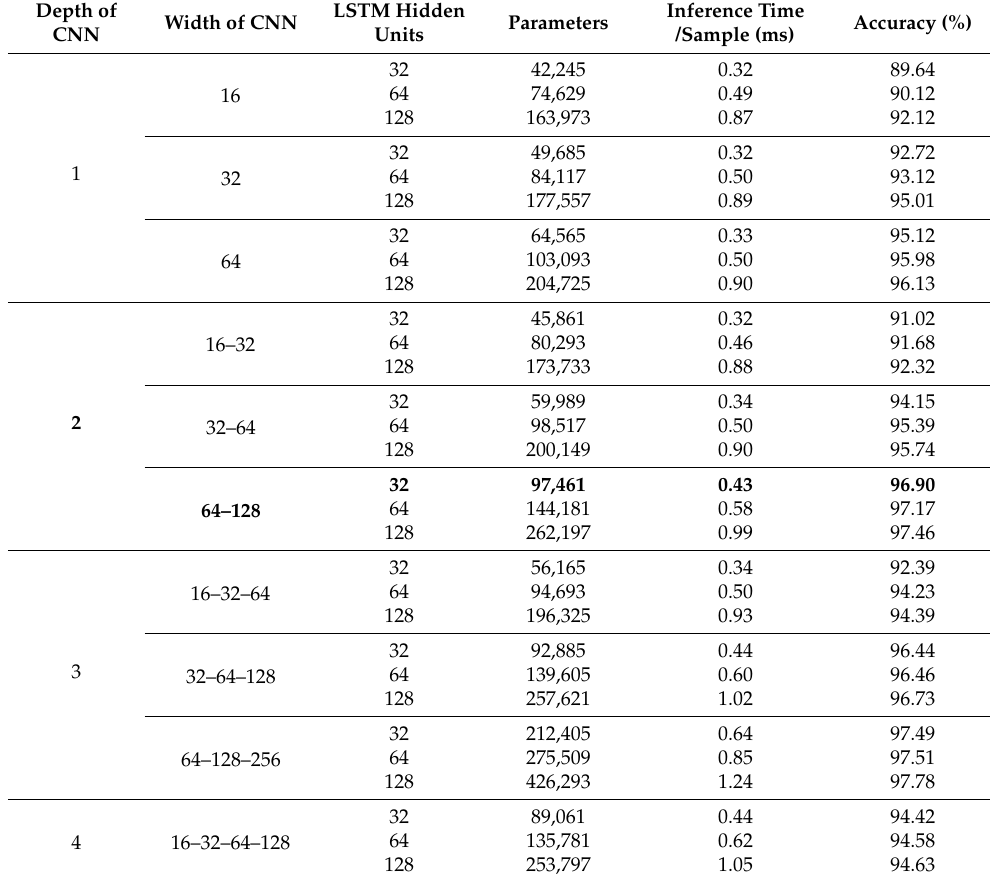
Table 2. Discussion of CLA network